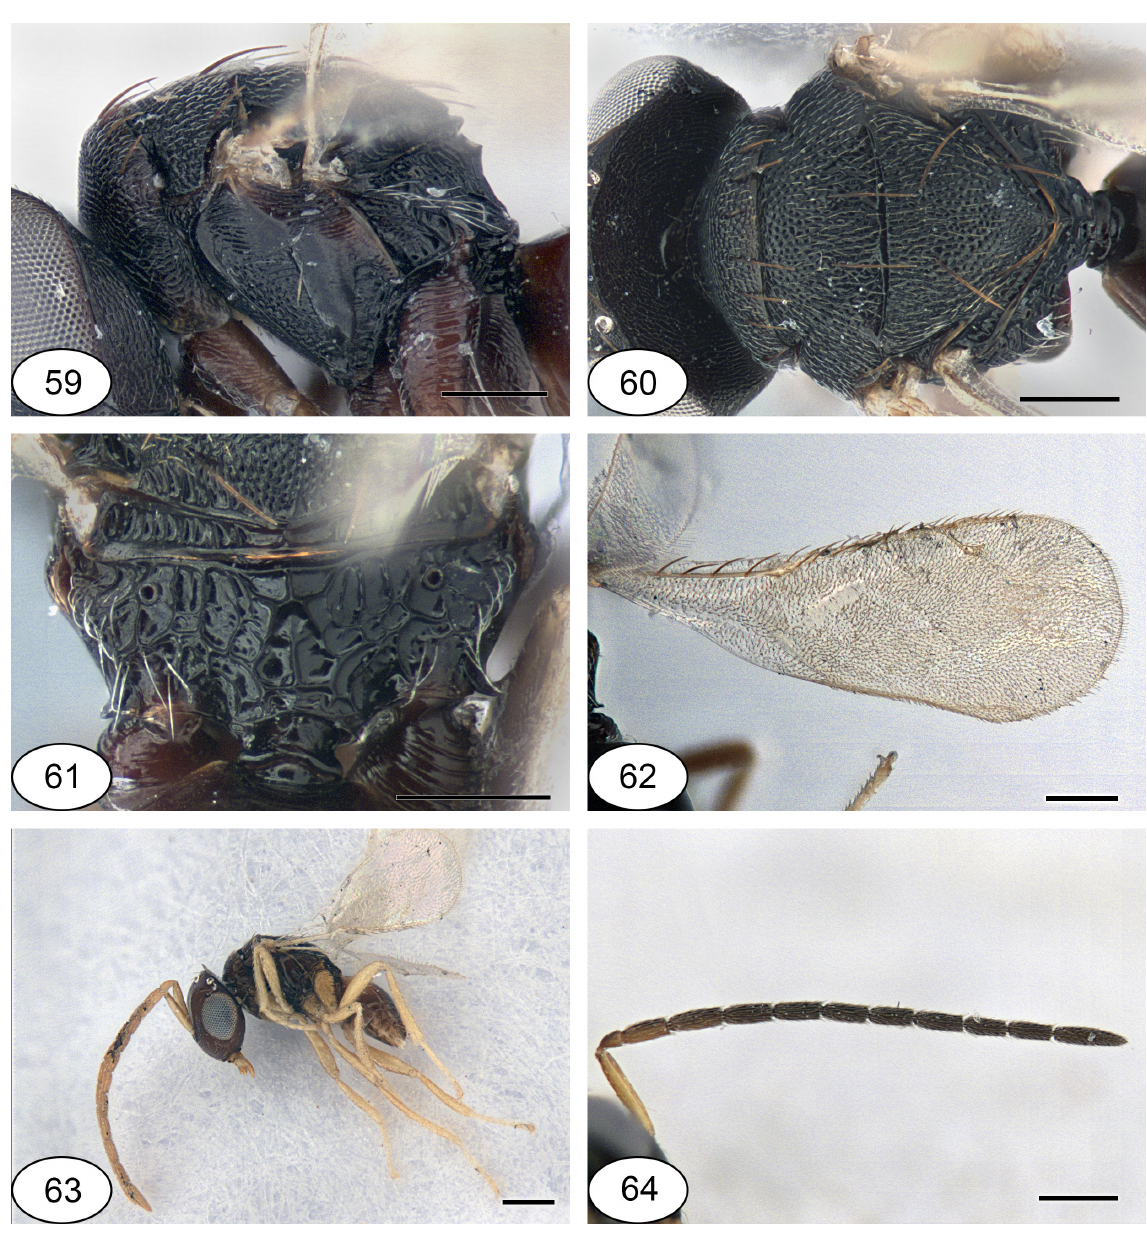
Figs 59–64. Netomocera desaegeri sp. nov. 59 . Holotype, ♀, mesosoma, lateral view. 60 . Holotype, ♀, mesosoma, dorsal view. 61 . Holotype, ♀, propodeum, dorsal view. 62 . Holotype, ♀, fore wing. 63 . Allotype, ♂, habitus, lateral view. 64 . Paratype, ♂, Kenya, antenna. Scale bars: 0.2